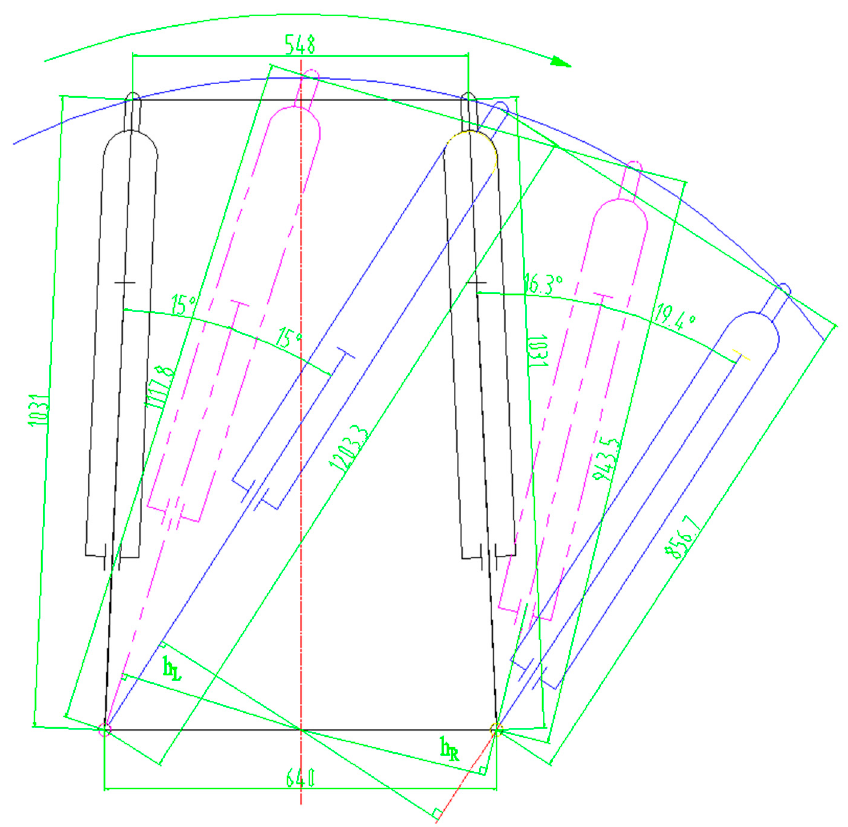
Figure 12. Steering mechanism.